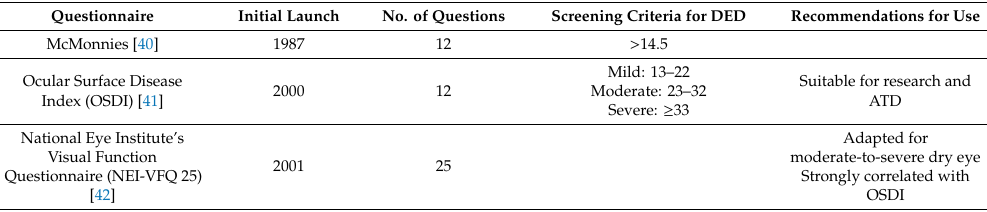
Table 2. Questionnaires used to evaluate symptoms of dry eye disease